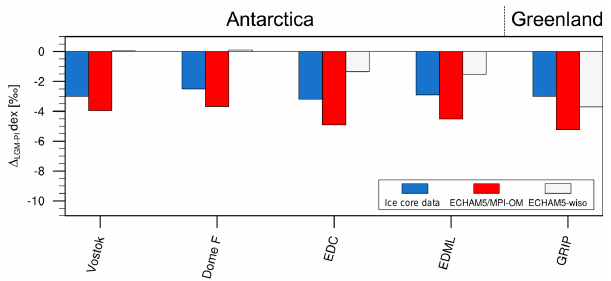
Figure 13. Comparison of annual mean LGM dex anomalies mea- sured in ice cores from Antarctica and Greenland (blue bars) vs. simulated LGM-PI dex changes (ECHAM5/MPI-OM: red bars; ECHAM5-wiso: light grey bars) at the ice core